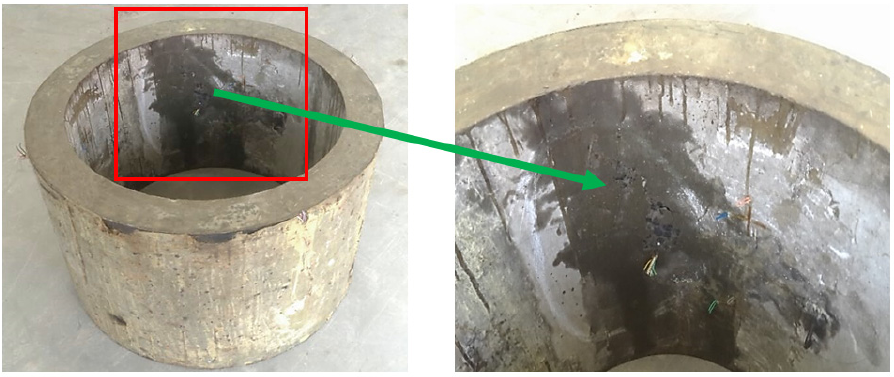
Figure 11. Shaft lining structure high-pressure loading device.